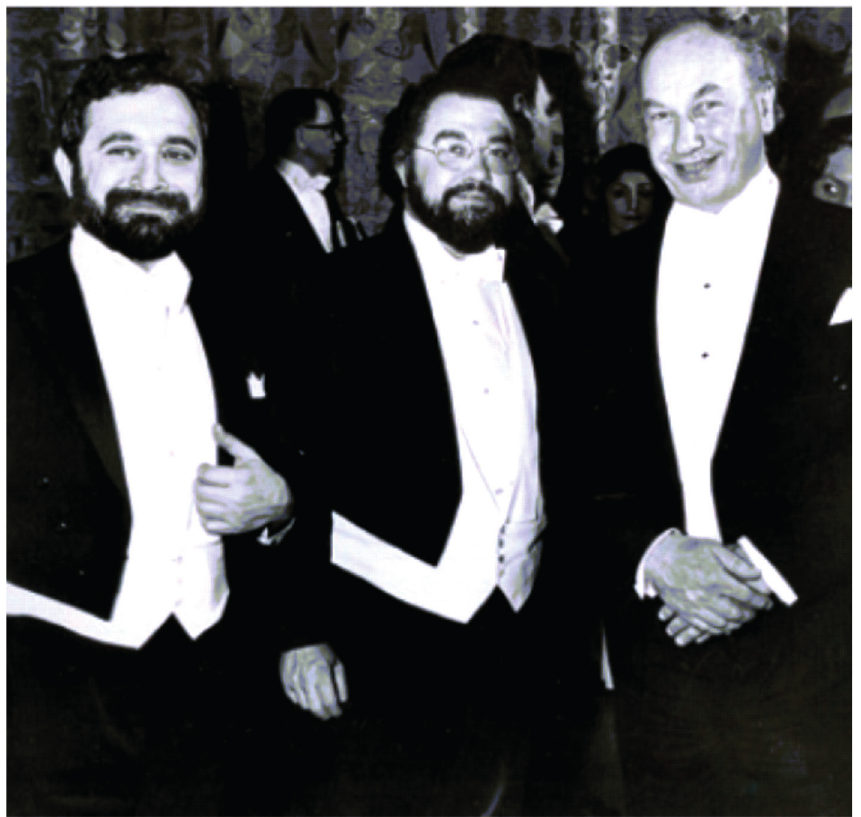
Figure 2 - From the right to the left: John R. Vane, Sergio H. Ferreira and Salvador Moncada in the ceremony of Nobel Prize granted to John Vane,